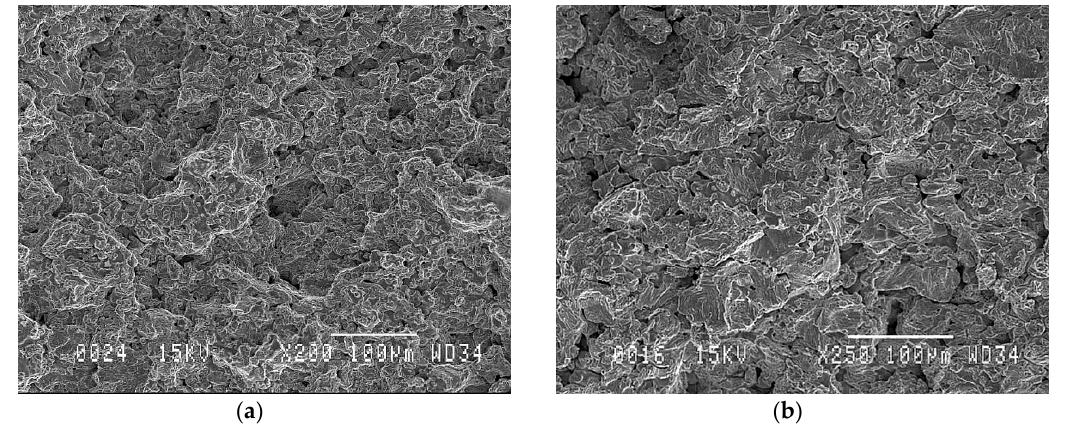
Figure 10. Fracture surfaces of the admixed PM steels tested at ( a ) R = 0.1; ( b ) R = 0.7. Intergranular fracture is the principal mode of crack propagation in both micrographs.